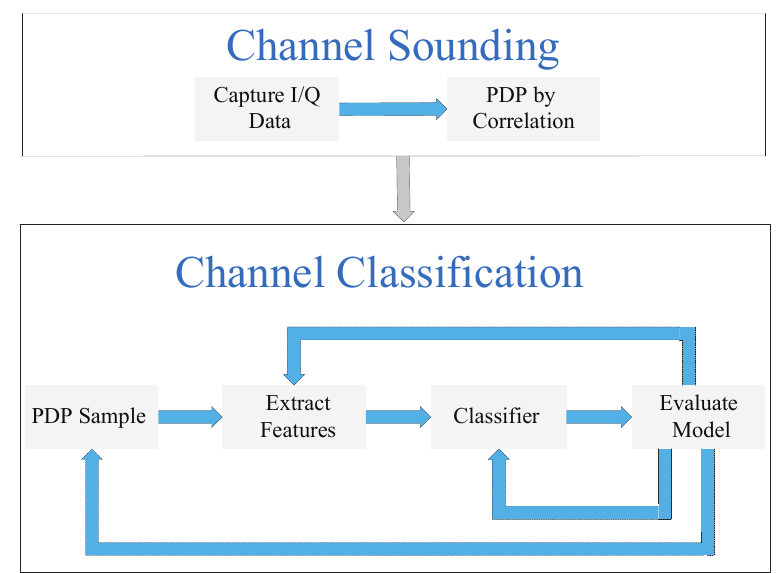
Figure 1. Overall flow chart of channel sounding and